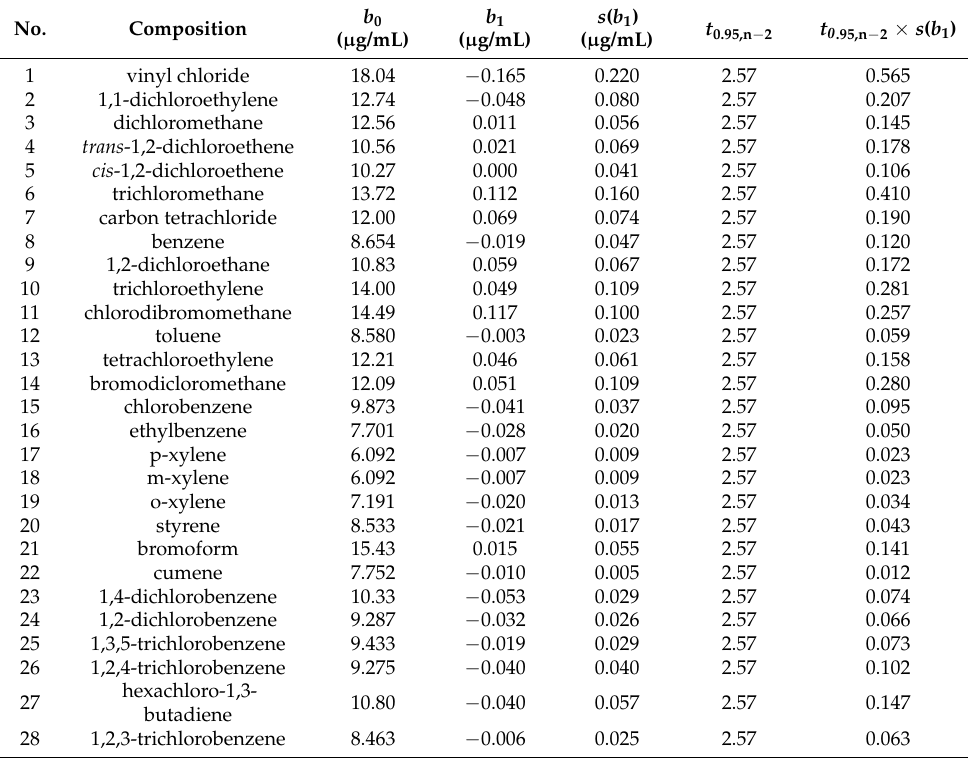
Figure 3. Results of vinyl chloride and m-xylene in spiking solution stored at room temperature at intervals of 15 months. Table 2. Stability study of VOCs spiking solution stored at room